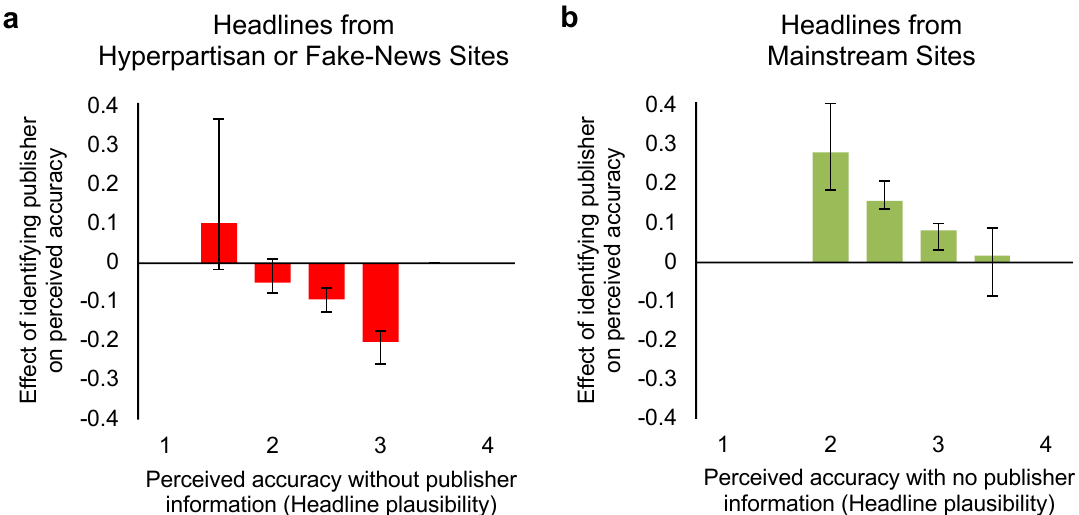
Figure 4. Identifying a headline’s publisher only changes accuracy perceptions insomuch as source trust and headline plausibility are mismatched. Headline plausibility as rated in the no-source control condition (x-axis) plotted against the